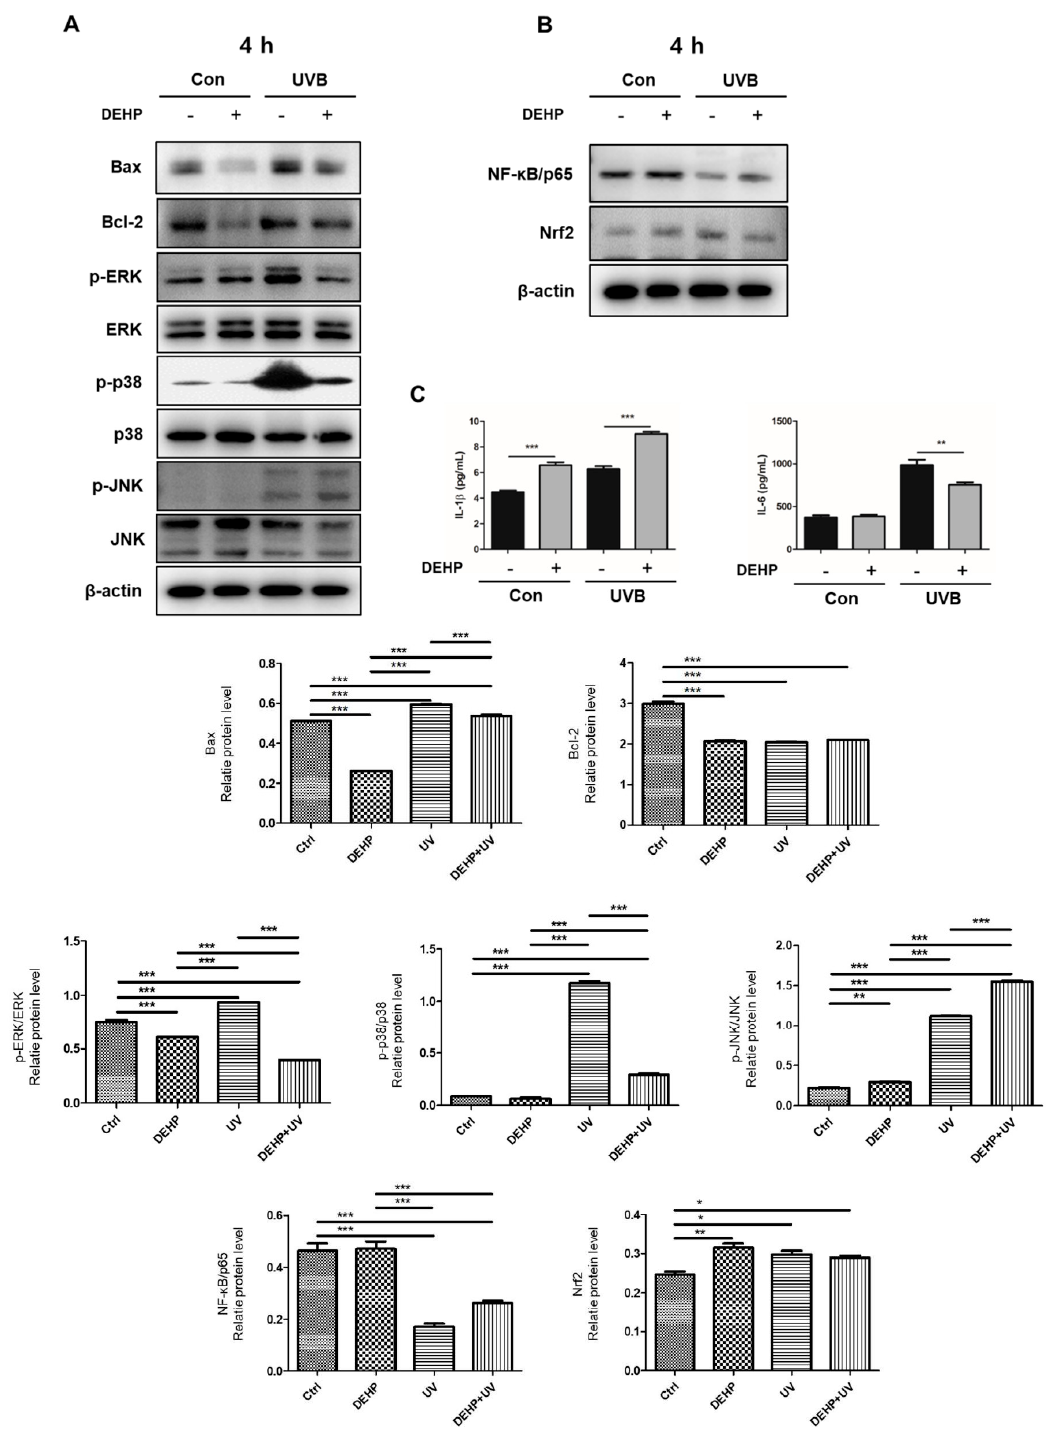
Figure 3. Effect of DEHP on apoptosis-related proteins, phosphorylation of ERK, p38 and JNK, suppression of NF- κ B/p65 and Nrf2, and signaling and induction of proinflammatory cytokines in 40 mJ/cm 2 UV-B-irradiated HaCaT cells. Western blot analysis was carried out with a primary antibody against Bax, Bcl-2, p-ERK, ERK, p-p38, p38, p-JNK, JNK, or β -actin ( A ) and NF- κ B/p65 and Nrf2 ( B ). Bands are representative of three independent experiments. The bar graphs (means ± SEM) in the bottom panels represent quantitative results of upper blots. The production of IL-1 β and IL-6 ( C ) was measured by ELISA (n = 6 for each group). The results are expressed as the means ± SEM. * p < 0.05; ** p < 0.01; *** p < 0.001 vs. control group.